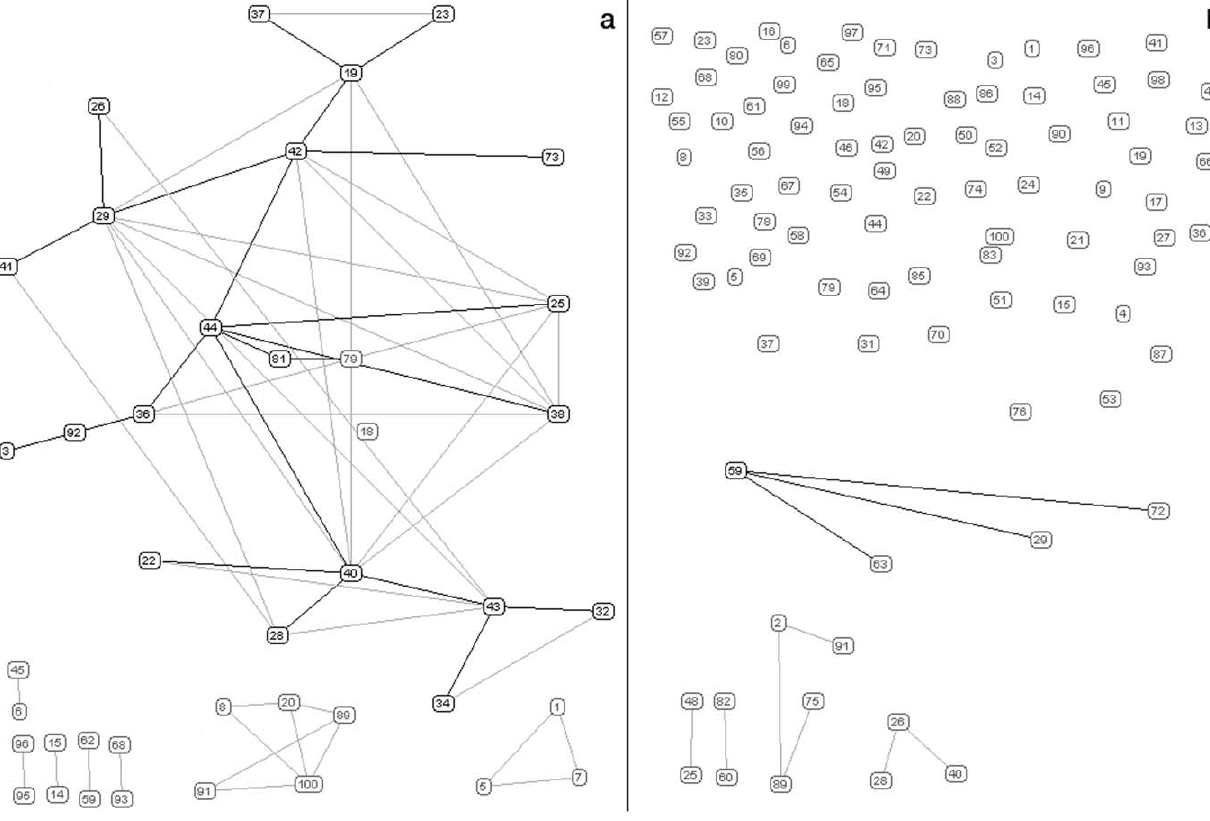
Figure 4. Gene regulation networks. Graphical representation of the inter-gene connection existing in the ALS group (a) and controls (b). The correspondence between the numerical labels and the gene ontology annotation is displayed in table 3.